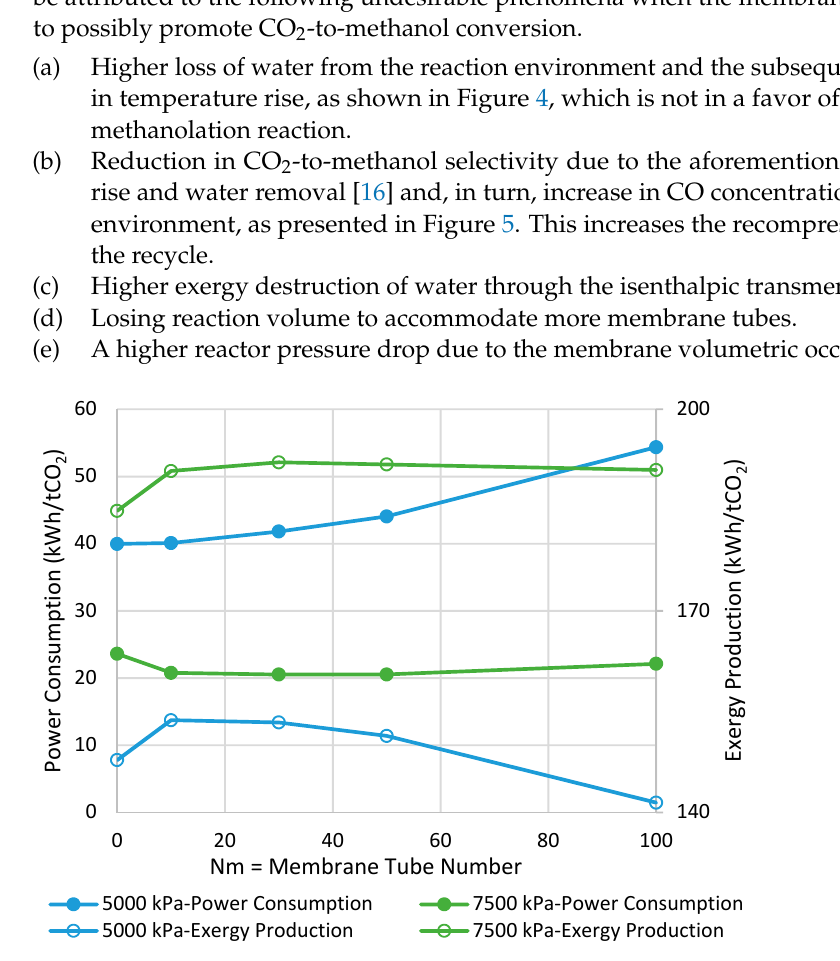
Figure 5. Carbon monoxide (CO) mole fraction through the adiabatic reactor’s length (Nm = 0 corresponds to CR). Figure 6 represents the concentration profiles for the existing species through the adiabatic CR and MR with Nm of 30 and 7500 kPa operating pressure (where the MR shows the highest impact). As shown, only the entrance section of the reactor is active. However, this active region of the reactor cannot be extended by the in situ water re- moval since the temperature rise as a dominating factor halts the reaction (see also Figure 4). After the temperature profile reaches 560 K for the CR and 569 K for the MR with Nm = 30, there are only slight changes in the species’ concentration, with some tendency to- ward CO production.